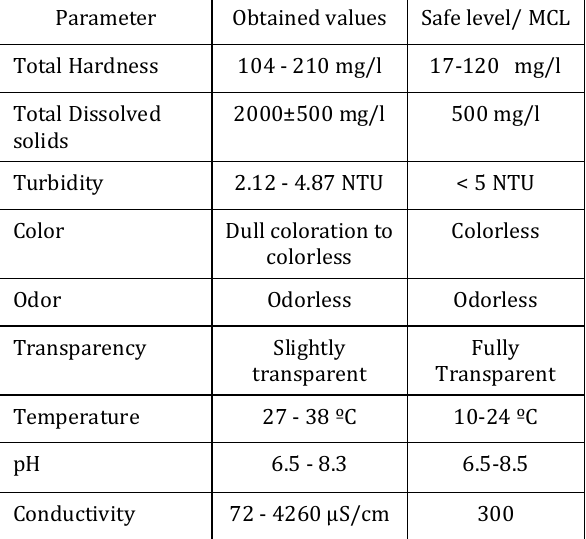
Table 1. Physical analysis of groundwater samples